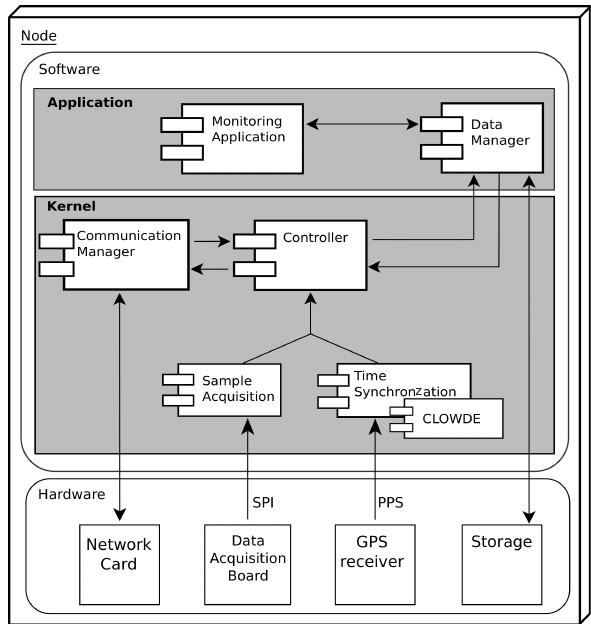
Figure 3. Node software Fig. 3: Node software architecture